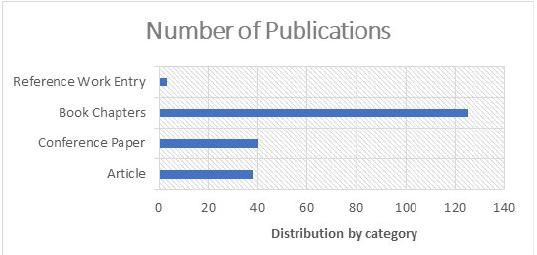
Figure 4. Type of publications in sciencedirect.